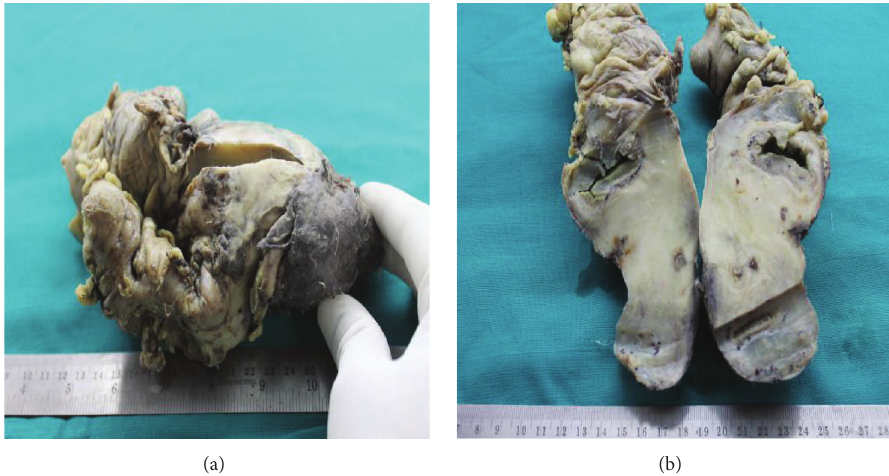
Figure 2: (a) Gross appearance before cutting it open. (b) Gross appearance after longitudinally opening the